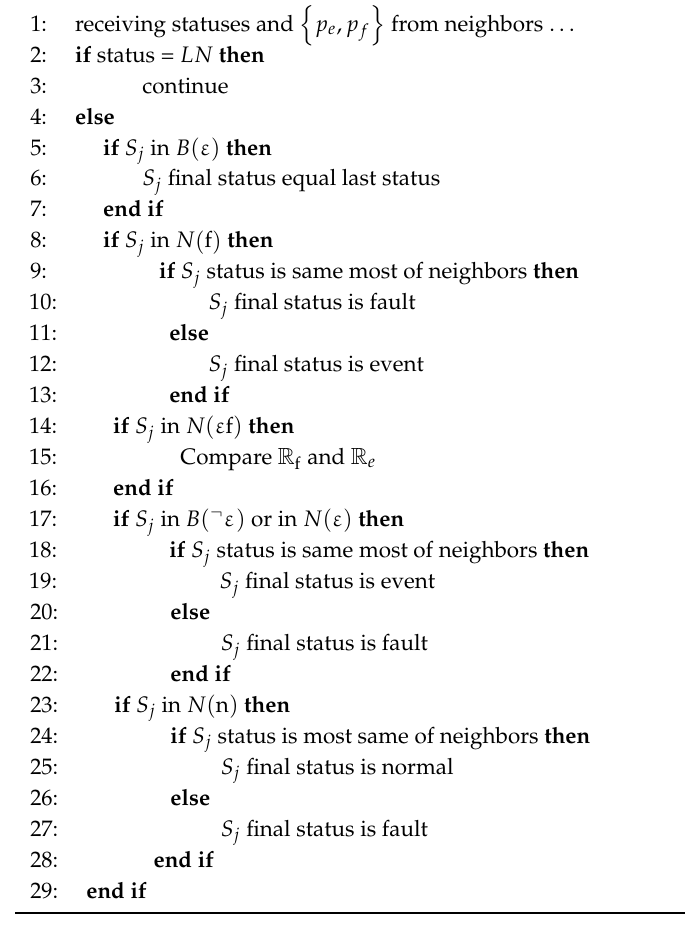
Algorithm 2. Spatial